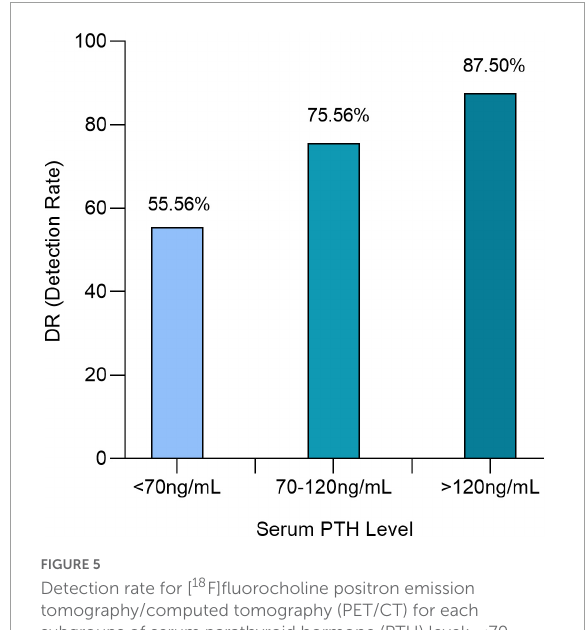
FIGURE5 Detection rate for [ 18 F]fluorocholine positron emission tomography/computed tomography (PET/CT) for each subgroups of serum parathyroid hormone (PTH) level: < 70, 70–120, and > 120